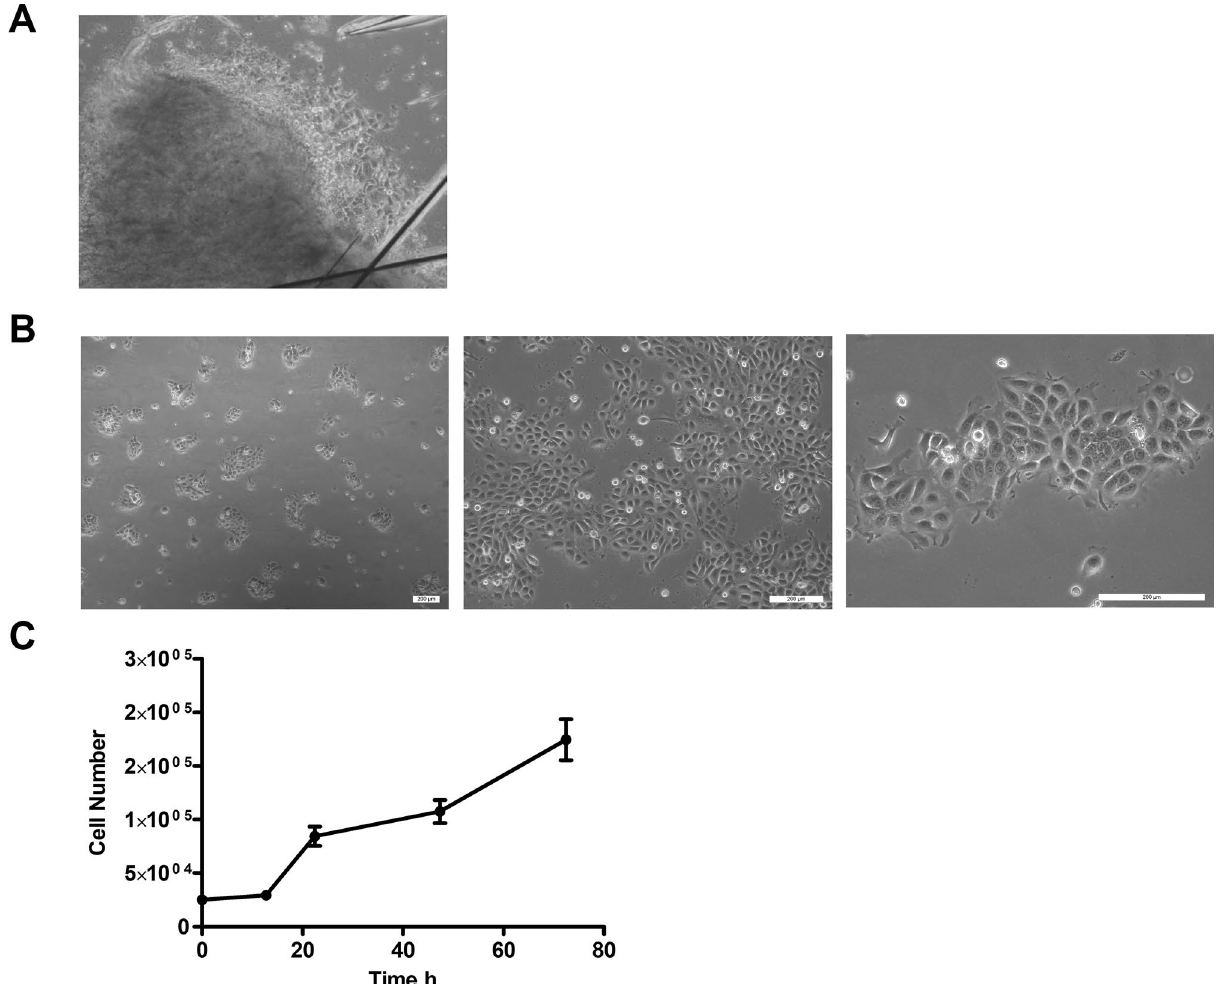
Figure 1. MaS-3 shows a distinct morphology. ( A ) Cells growing out of tumour fragment 4 days after seeding. ( B ) Morphology of MaS-3 cells passage 10 under phase contrast microscope (a) ×5, (b) ×10, (c) ×20. ( C ) Growth curve of MaS-3 cells. Error bars indicate standard error of